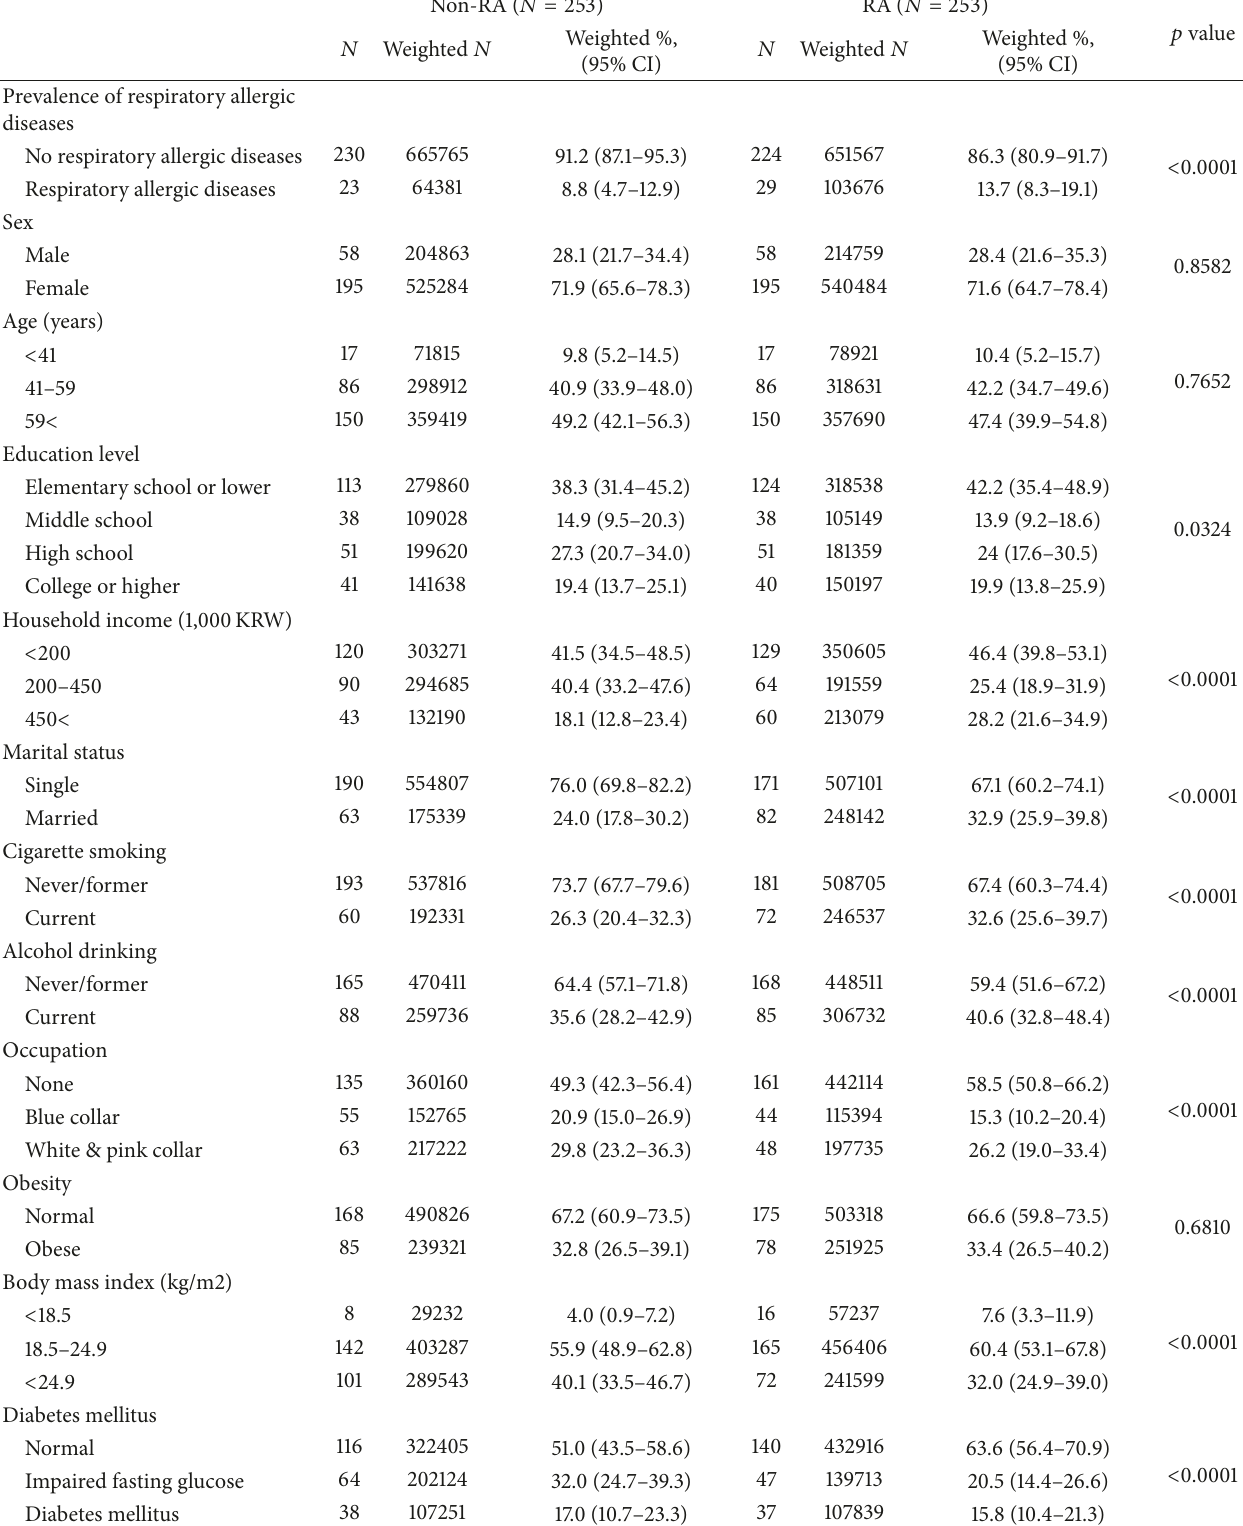
Table 1: Baseline characteristics of the study population in KNHANES